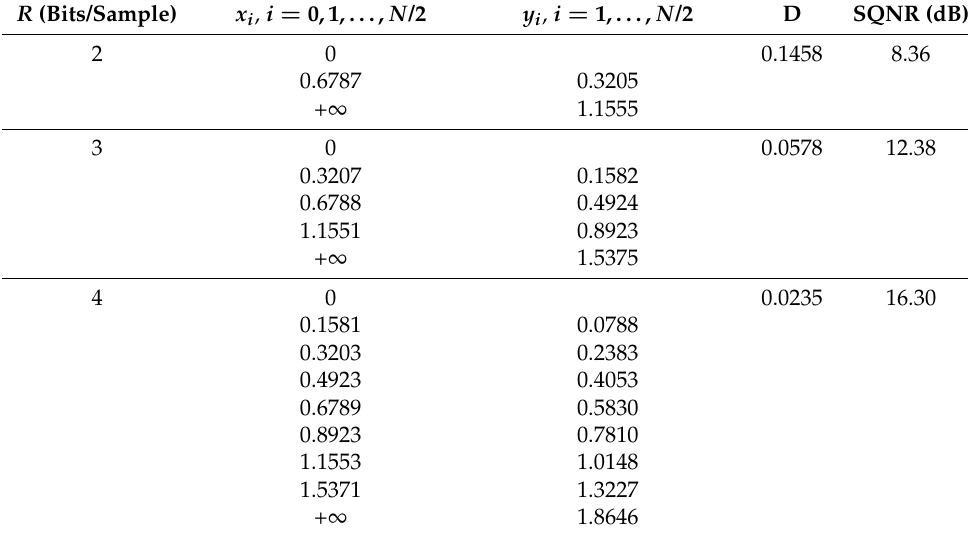
Table 9. Scalar quantization designed to have equiprobable cells when quantizing a Gaussian variable with zero mean value and unit variance R